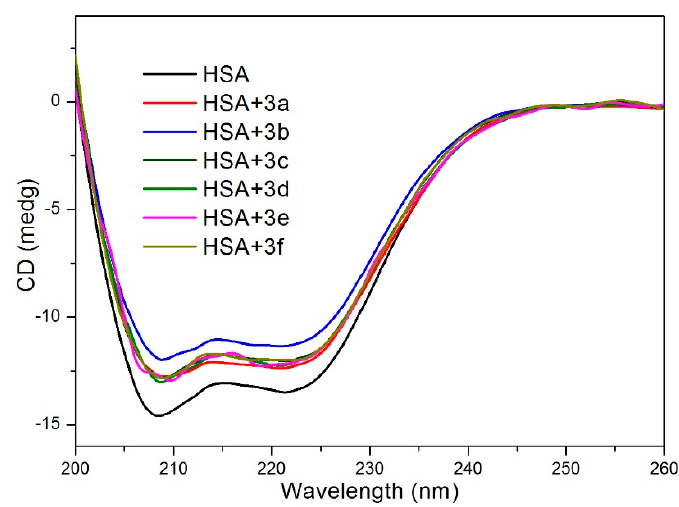
Figure 5 . Far-UV circular dichroism (CD) spectra of the PDQL-HSA system: C HSA = 1.0 × 10 − 6 M and